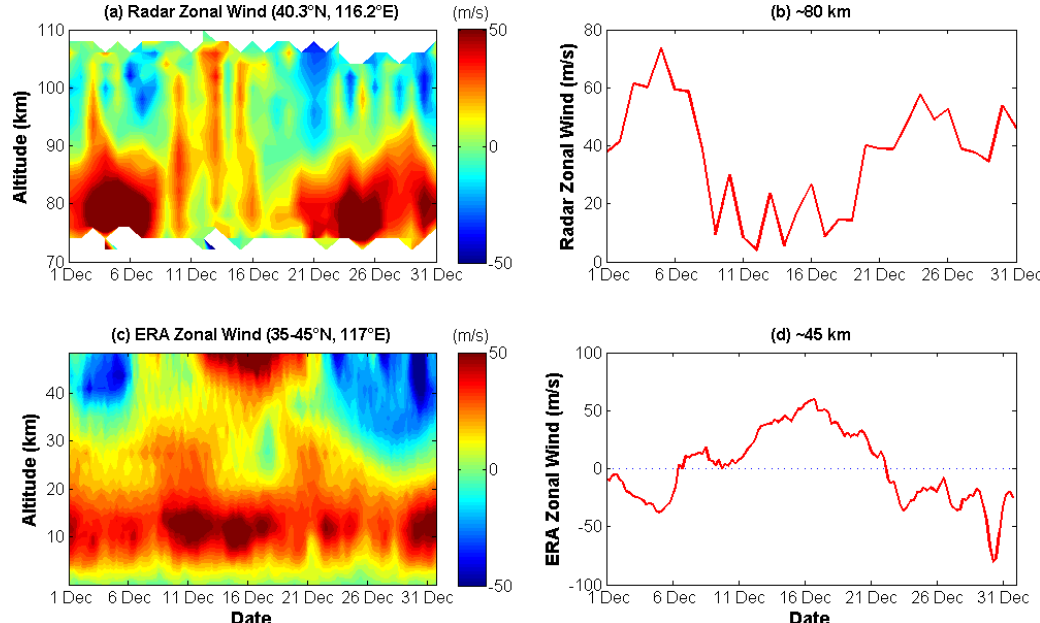
Figure 8. (a, c) The temporal variations of zonal wind with altitude near the lidar site in December 2014 obtained from meteor radar (70– 110km, 40.3 ◦ N, 116.2 ◦ E) and ERA reanalysis data (0–48km, 35–45 ◦ N, 117 ◦ E), respectively; (b, d) the temporal variations of zonal wind near 80 and 45km, respectively (red lines). The blue dashed lines indicate zero